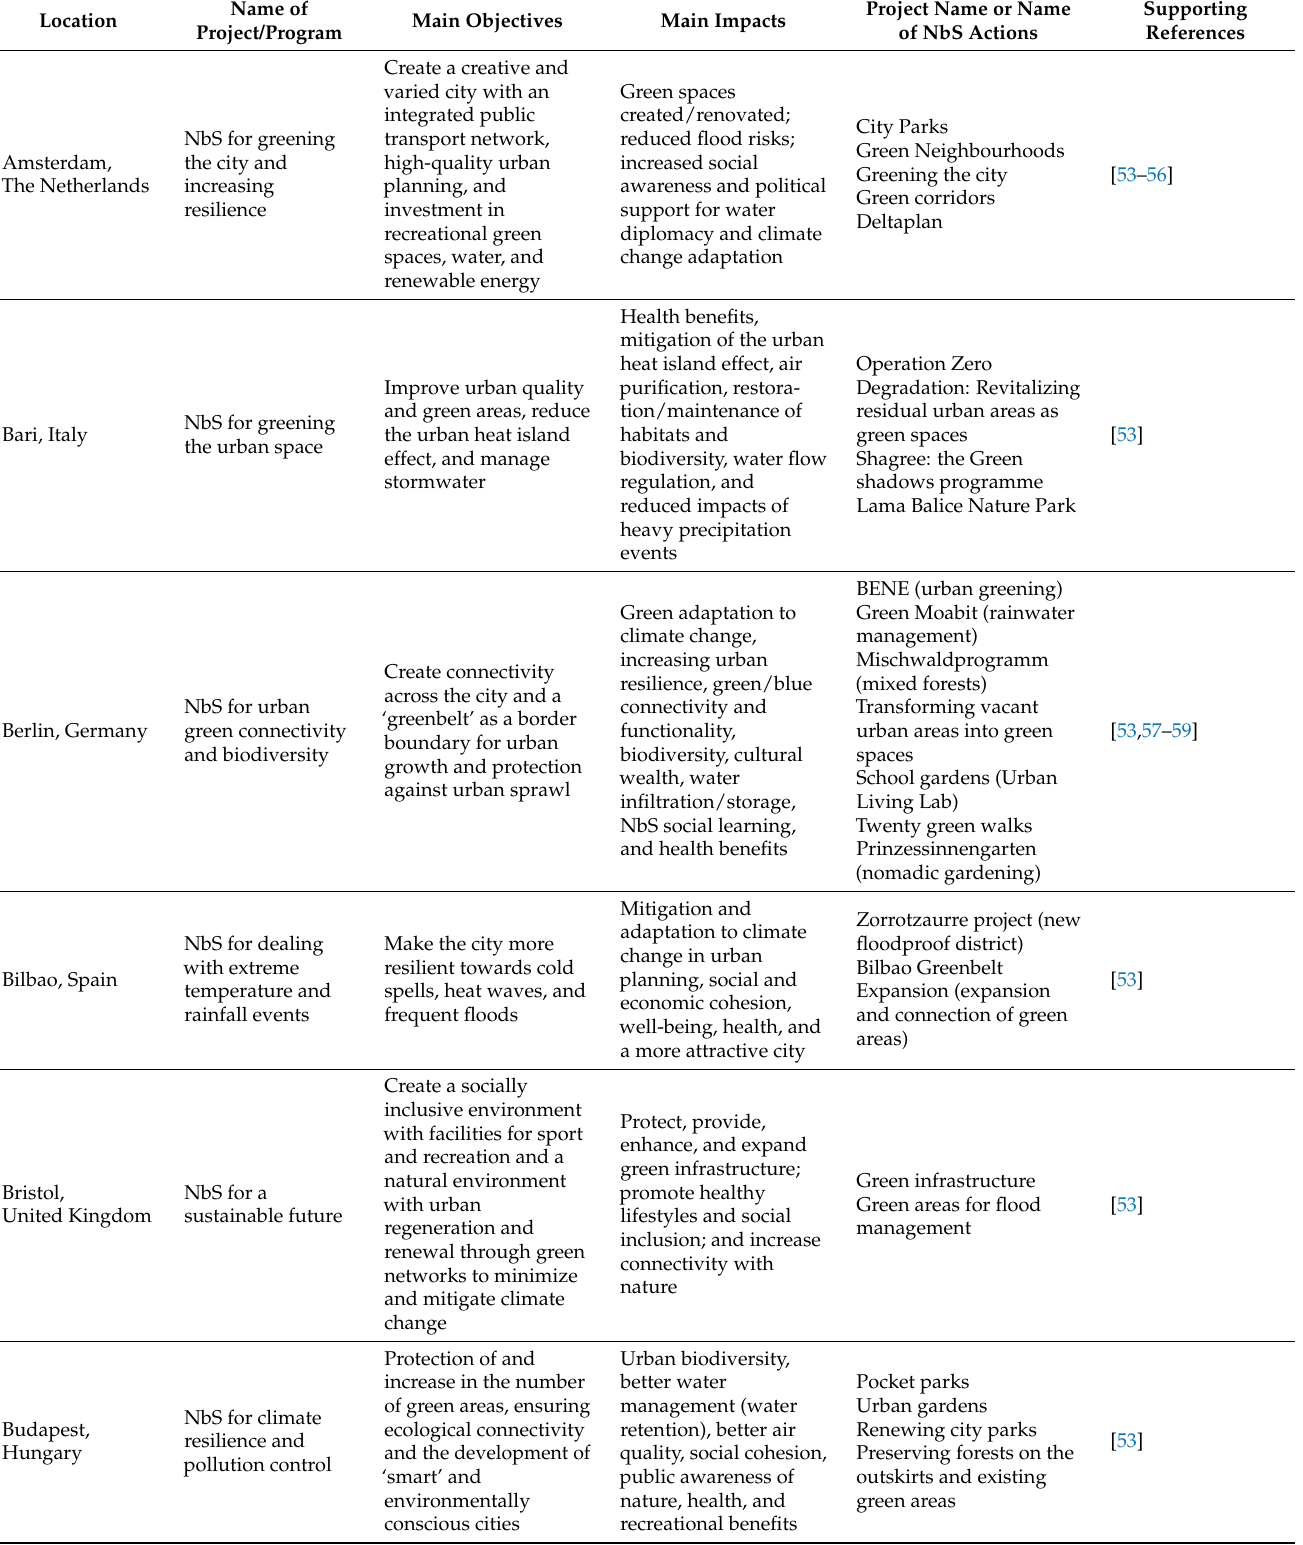
Table 3. List of cities and their